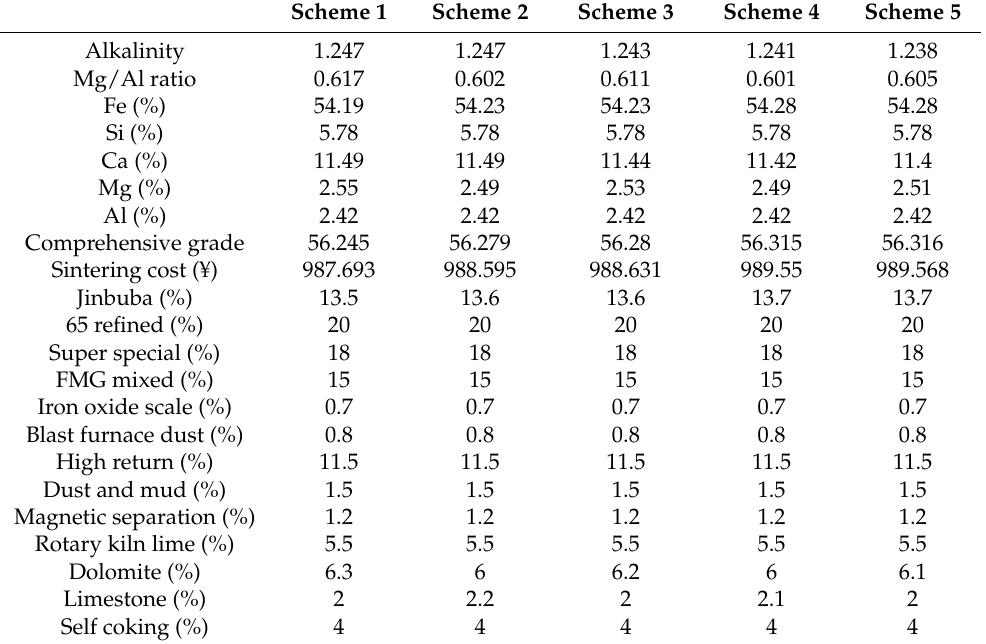
Table 6. Optimal sintering batching scheme aiming at higher iron grade.